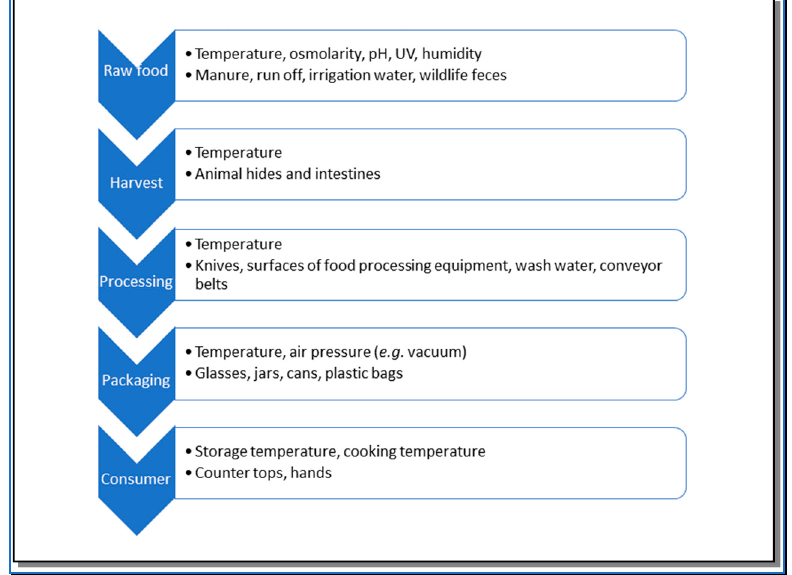
Figure 1. General schematic of a food processing chain. For each processing step, the first bullet lists environmental conditions that can impact presence of foodborne pathogens, and the second bullet lists sources of contamination.